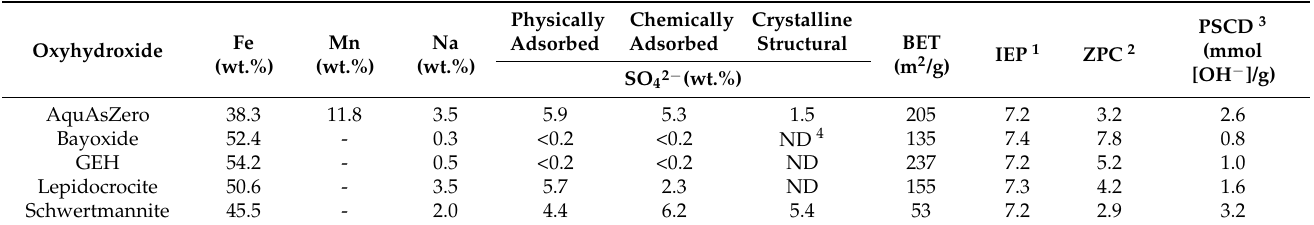
Table 1. Main physicochemical characteristics of five examined different iron oxyhydroxides